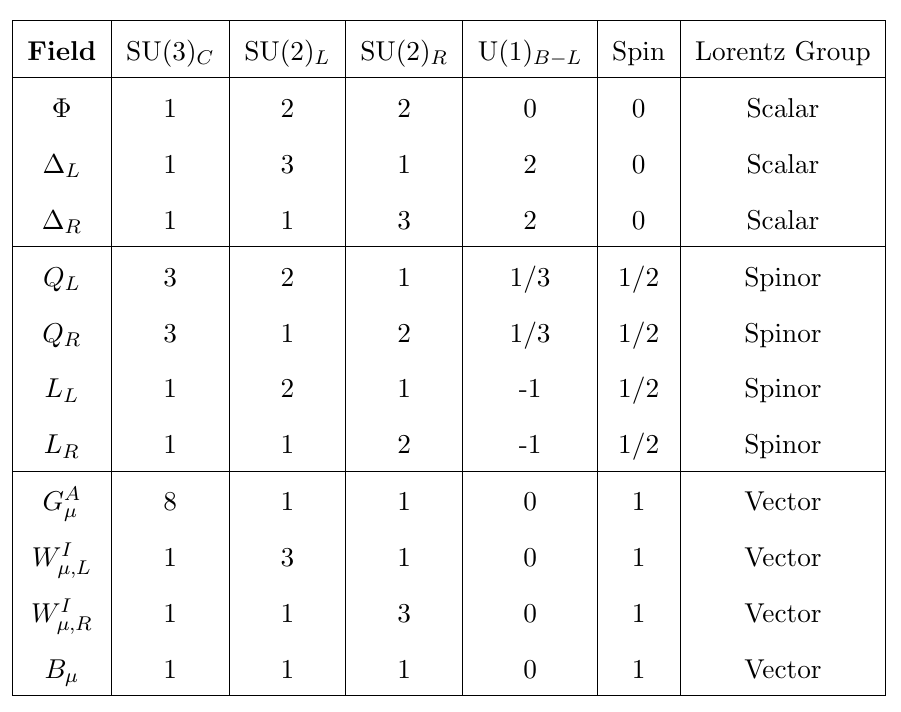
Table 13. MLRSM: quantum number of the